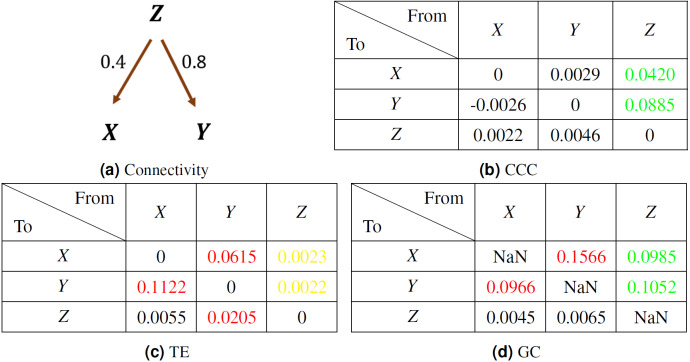
Mean causality values estimated using CCC (B), TE (C) and GC (D) for a system of three AR variables coupled as in (A).True positives are in green, true negatives in black, false positives in red and false negatives in yellow.